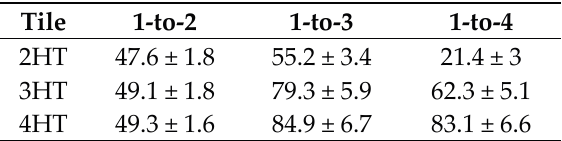
Table 1. Distance in angstroms between connection points on each tile observed in molecular dynamics simulation. Uncertainty associated with each measurement is represented by the standard deviation of the data. 1-to-2 represents the distance along one helix, 1-to-3 is the diagonal across a tile, and 1-to-4 is the distance between helices on one tile